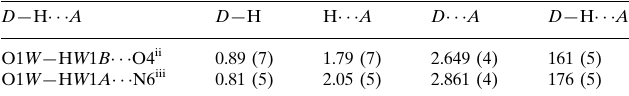
Hydrogen-bond geometry (A˚ , (cid:2)